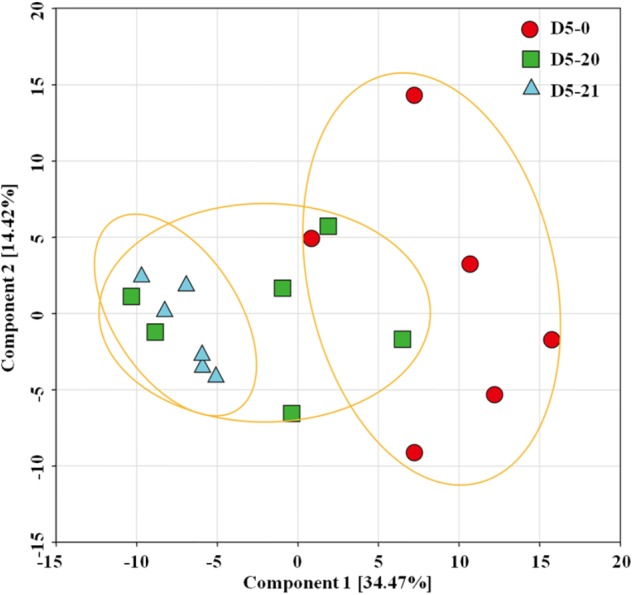
Principal component analysis (PCA) score plots of metabolome data from the cambium of transgenic and non-transgenic poplar. PCA score plot of the three lines. The red circle indicates non-transgenic line D5-0, while the green square and blue triangle indicate multi-gene transgenic line D5-20 and D5-21, respectively. The plot displays PC1 on the ordinate axis and PC2 on the abscissa.